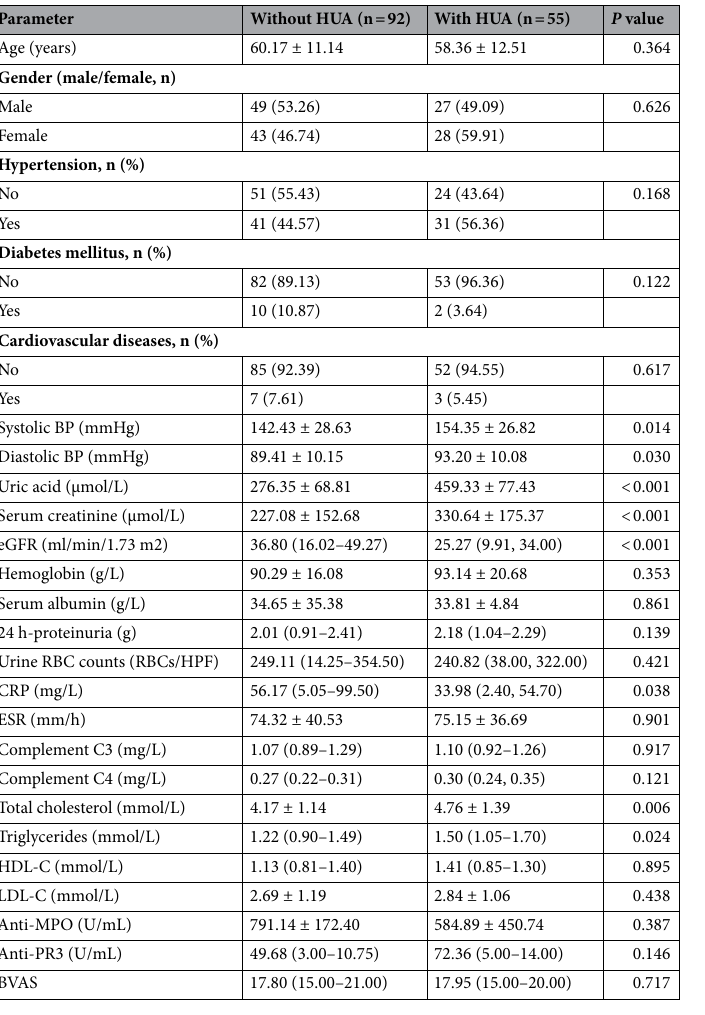
Table 1. Demographics and clinical characteristics of 147 ANCA-associated renal vasculitis patients with and without hyperuricemia. Values for continuous variables were given as the mean ± standard deviation (for normally distributed data) or median (interquartile range [IQR]; for nonnormally distributed data). Values for categorical variables were given as number or number (percentage). HUA hyperuricemia, eGFR estimated glomerular filtration rate, BP blood pressure, RBC red blood cell, ESR erythrocyte sedimentation rate , CRP C reactive protein, HDL-C high-density lipoprotein cholesterol, LDL-C low-density lipoprotein cholesterol, Anti- MPO myeloperoxidase antibody, Anti-PR3 protease 3 antibody, BVAS Birmingham Vasculitis Activity Score. P value: comparison between two groups. P < 0.05 was considered